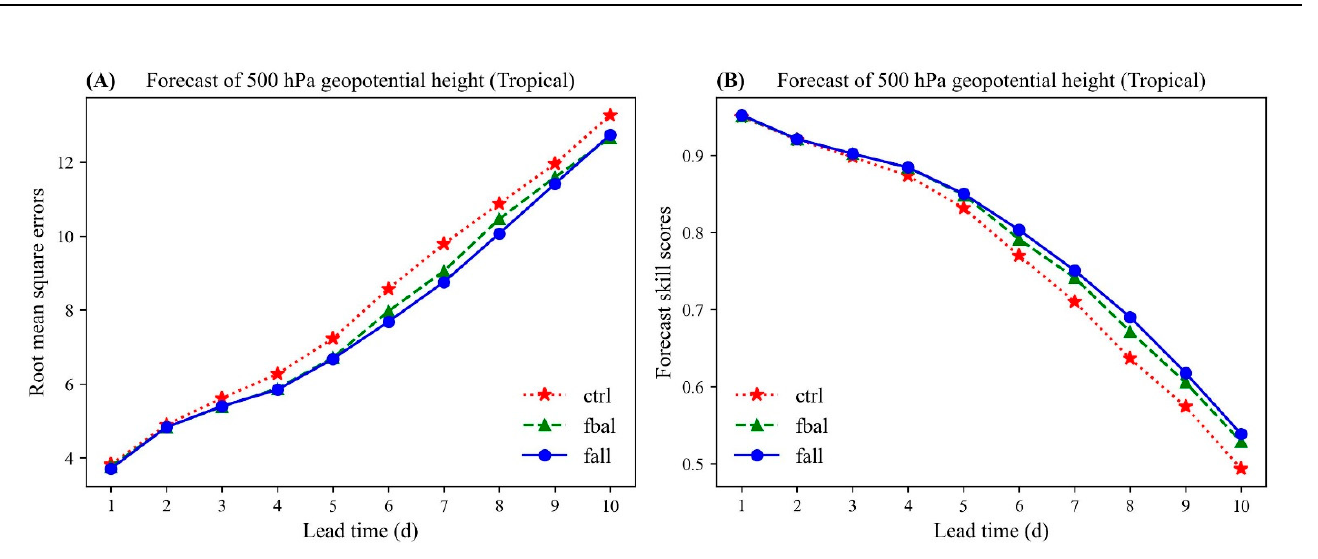
Figure 11. Root mean square errors ( A ) and forecast skill scores ( B ) of geopotential height forecasts at 500 hPa. Scores and errors are averaged over the period 1–31 October 2020 for tropical regions. Table 3. Average track and intensity errors of all forecasts from three experiments.